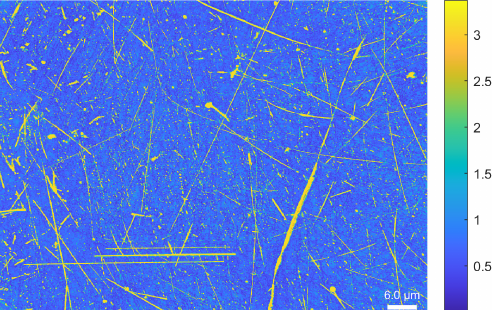
Figure 11. Multi-scale saliency map estimated with the statistics descriptors calculated from an RTI acquisition of the watch dial. Saliency map multi-scale Global , [ 512;256;3 ] , [ 256;128;3 ] , [ 128;64;3 ] .